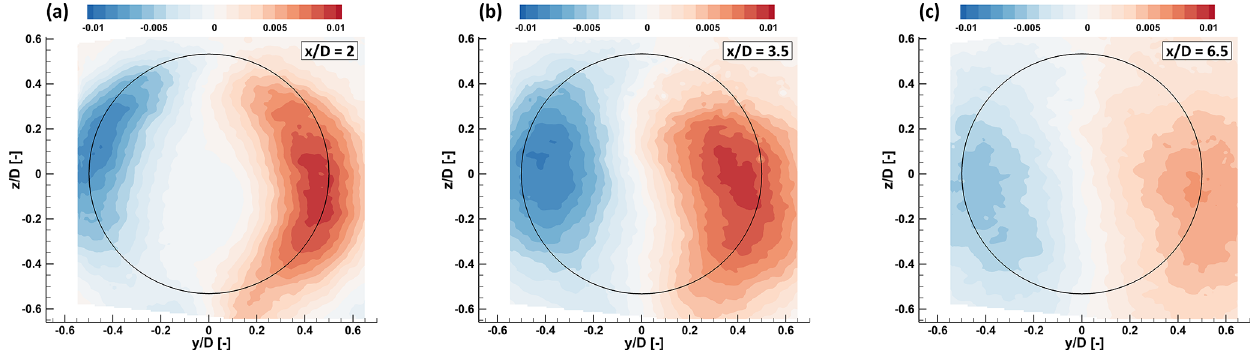
for UTD-HT inflow at several downstream distances. The black circle denotes the hub